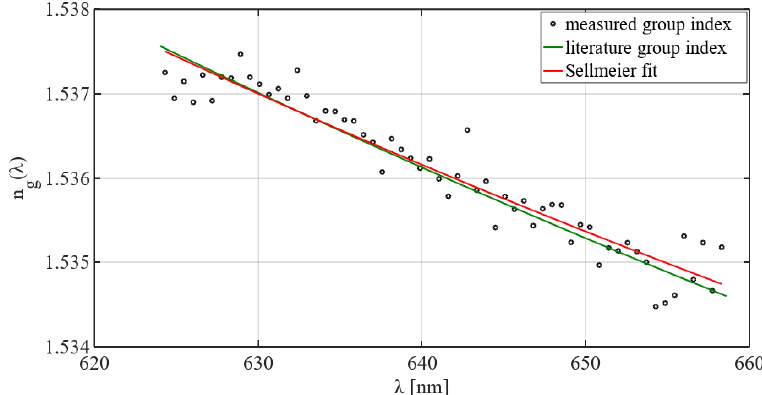
Figure 3. Plot of the measured group refractive index n g ( λ ) of N-BK7 which was calculated using the WPDE approach and its corresponding Sellmeier fit in comparison to the literature values according to [36].